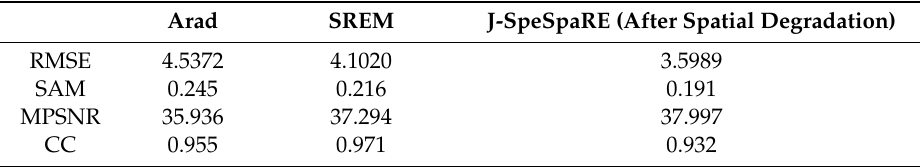
Table 4. Spectral assessment of our proposed method and spectral resolution enhancement methods on Cuprite